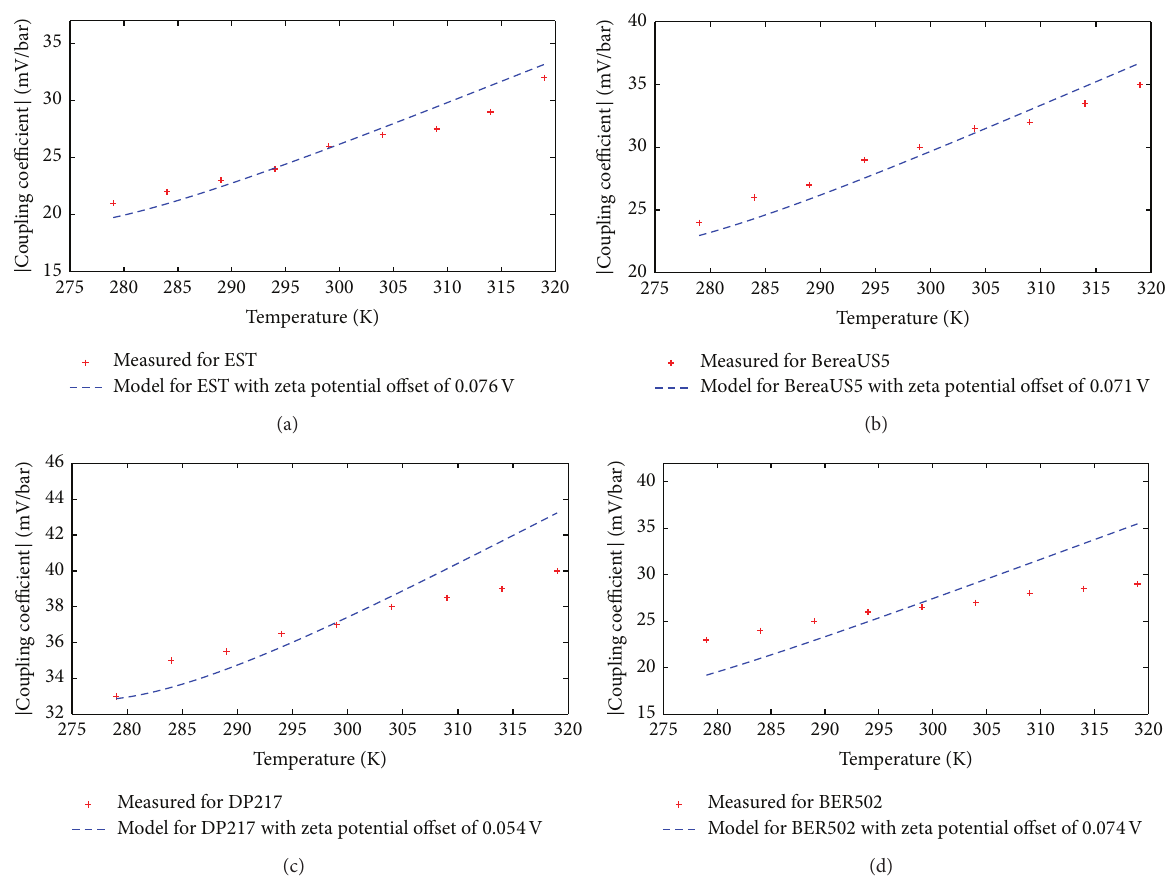
Figure 9: (a) is for the EST sample, (b) is for the BereaUS5 sample, (c) is for the DP217 sample, and (d) is for the BER502 sample.